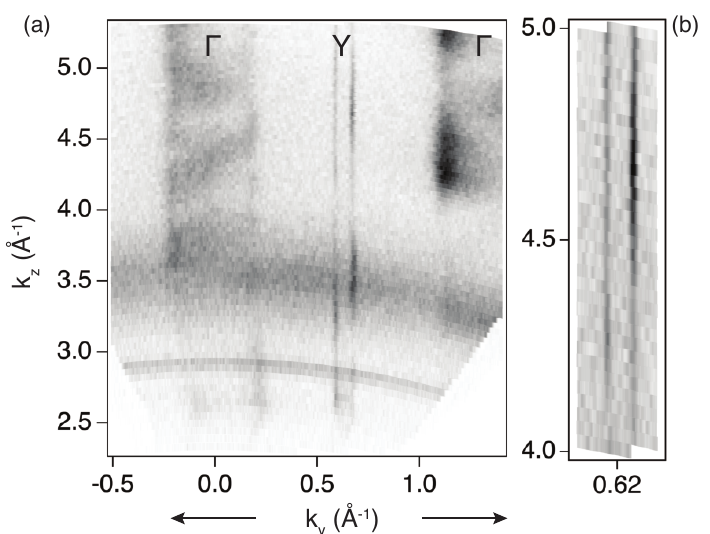
-dependence of the electronic states. (a) k Figure 3: k z Γ − Y cut, obtained from photon energy dependent ARPES experiments (h ν = 20-120 eV). (b) Zoom-in on the Y state over a k of these